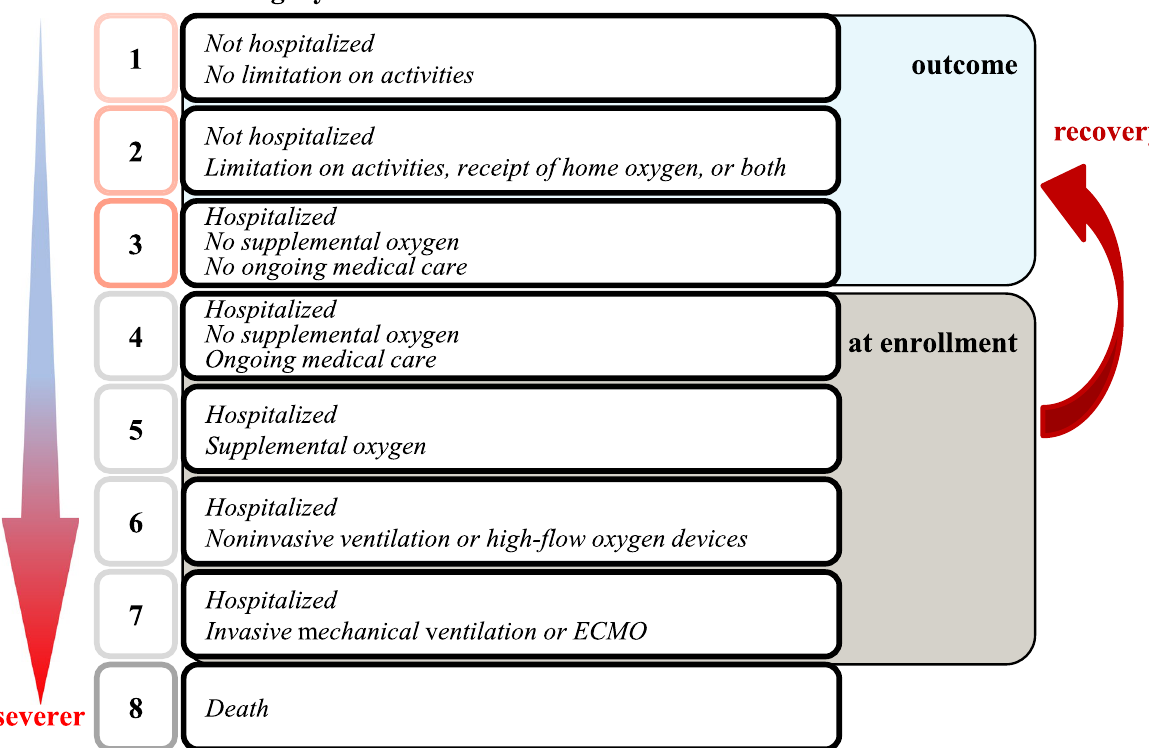
Fig. 3 NIAID 8-point ordinal scale was used for the patient inclusion criteria and treatment endpoint in ACCT-2 study. NIAID 8-point ordinal scale was used for the patient inclusion criteria and treatment endpoint. Patients assigned as level 4 (hospitalized but not requiring oxygen supplementation; requiring continuous therapy) to level 7 (hospitalized and managed by invasive mechanical ventilation or ECMO) were included. The primary outcome was clinical improvement to level 1 (not hospitalized or restricting activities) to level 3 (hospitalized but not requiring oxygen supplementation; not requiring continuous therapy) on days 14 by the